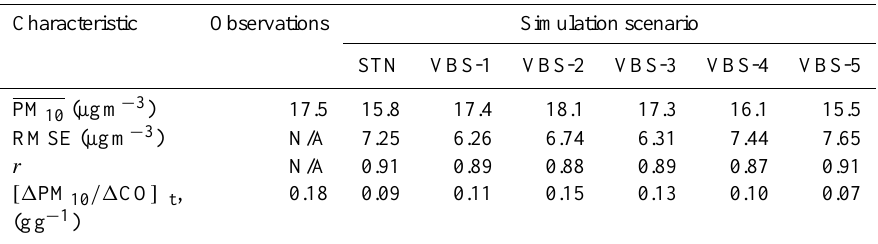
Table 5. Characteristics of simulation data (after bias correction) compared to air pollution measurements at the Maaherrankatu site in